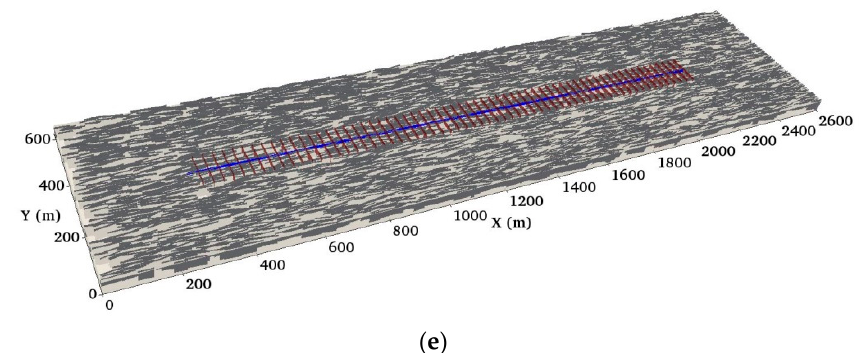
Figure 12. Numerical model with complex fractures: ( a ) without natural fractures; ( b ) 0.05 natural fracture/m; ( c ) 0.1 natural fracture/m; ( d ) 0.2 natural fracture/m; ( e ) 0.5 natural fracture/m. Blue line indicates the wellbore. Red and grey pieces represent hydraulic fractures and natural fractures respectively. Table 11. Summary of results for huff-n-puff with different natural fracture density.